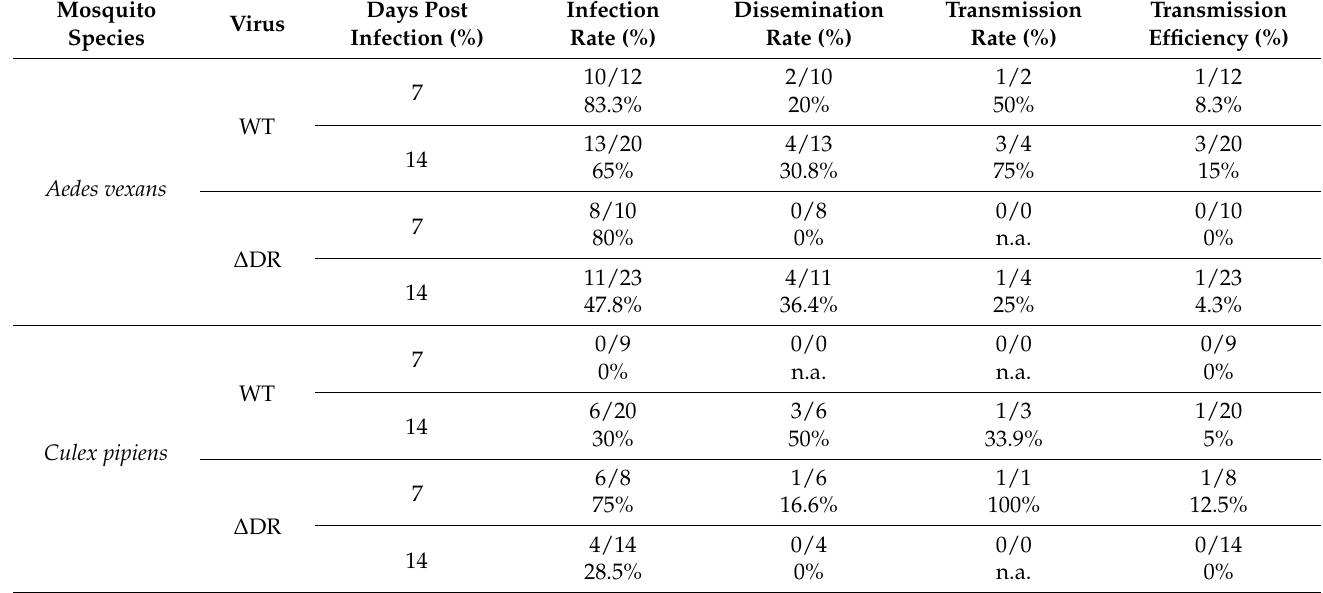
Table 3. Infection, dissemination, transmission rates, and transmission efficiencies for CHIKV-WT and CHIKV- ∆ DR at d7 and d14 post infection in Ae. vexans and Cx. pipiens. Mosquito